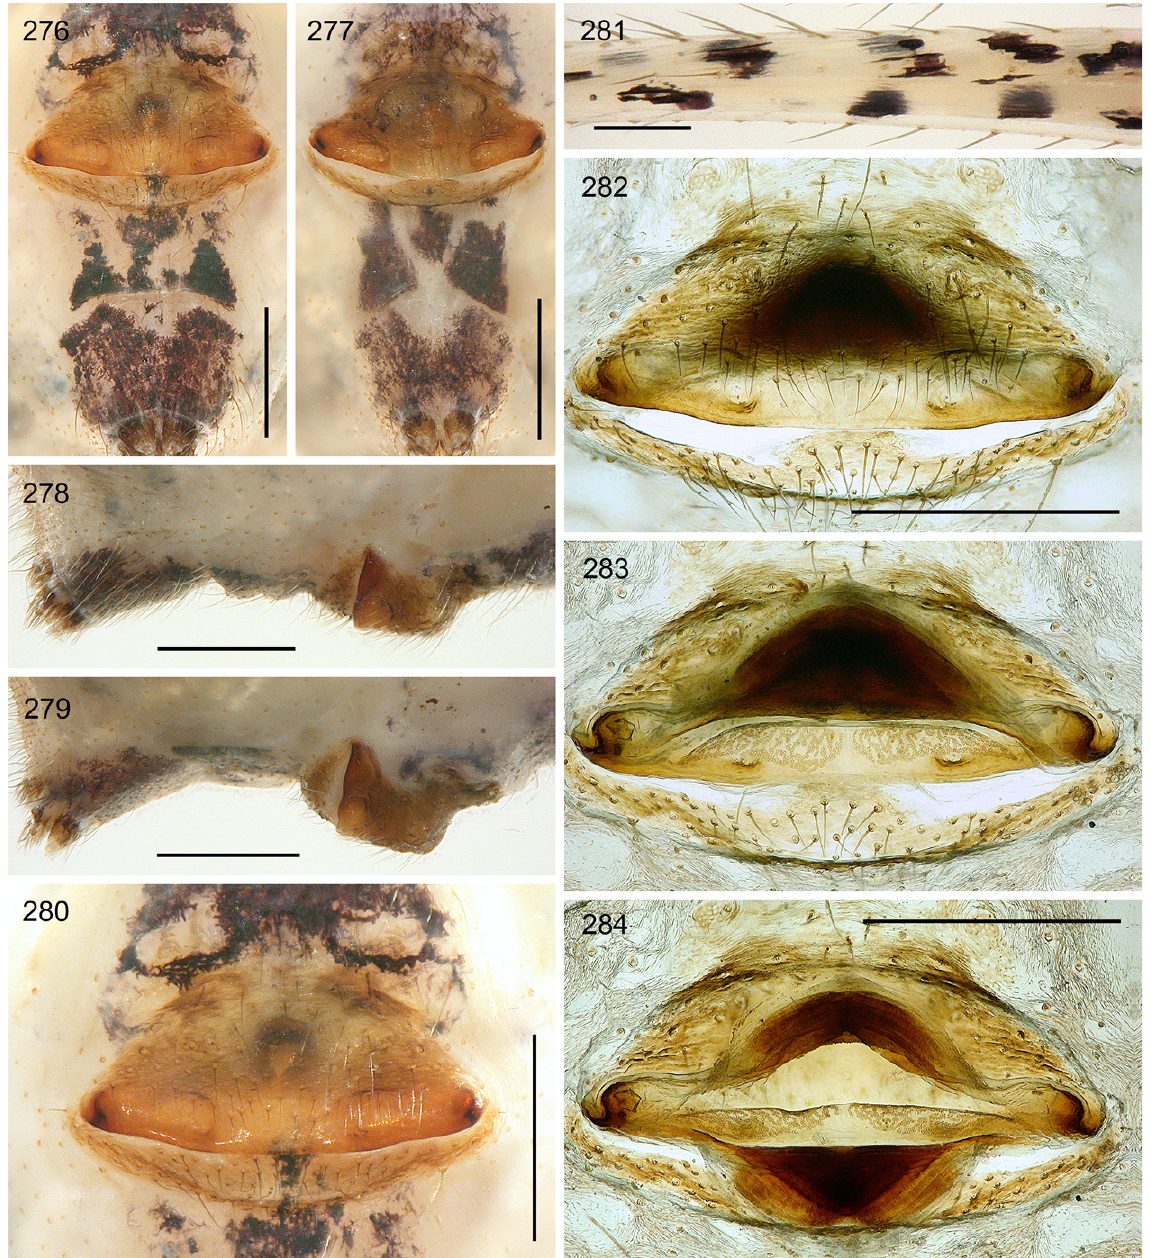
Figs 276–284. Maghreba gharbija gen. et sp. nov.; females from Morocco, 4 km E of Ghazoua (276, 278, 280–284; ZFMK Ar 22380) and from Morocco, Gourizim (277, 279; ZFMK Ar 22384). 276– 279 . Abdomens, ventral and lateral views. 280 . Epigynum, ventral view. 281 . Right femur 2, ventral view. 282–284 . Cleared female genitalia, ventral view, regular dorsal view, and dorsal view with dorsal arc tilted backwards. Scale bars: 276–280, 282–284 = 0.5 mm; 281 = 0.2